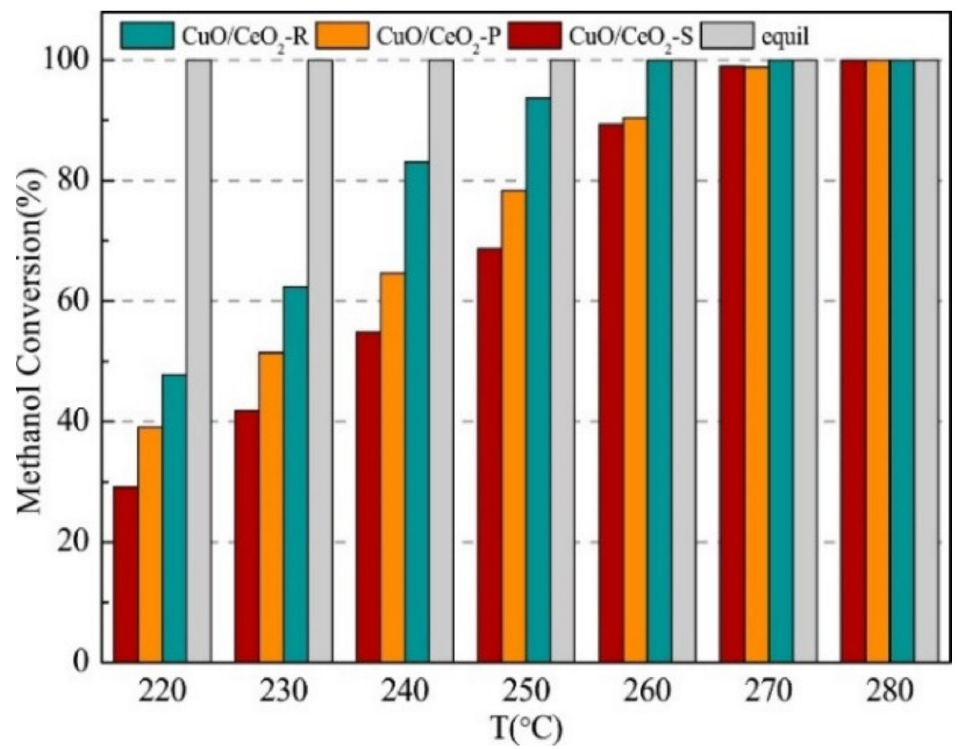
Figure 8. Catalytic activity for the SRM reaction as a function of temperature. (Experimental conditions: S/C = 1.2, GHSV = 800 h − 1 , no carrier gas.) (Adapted from [87], copyright 2019,